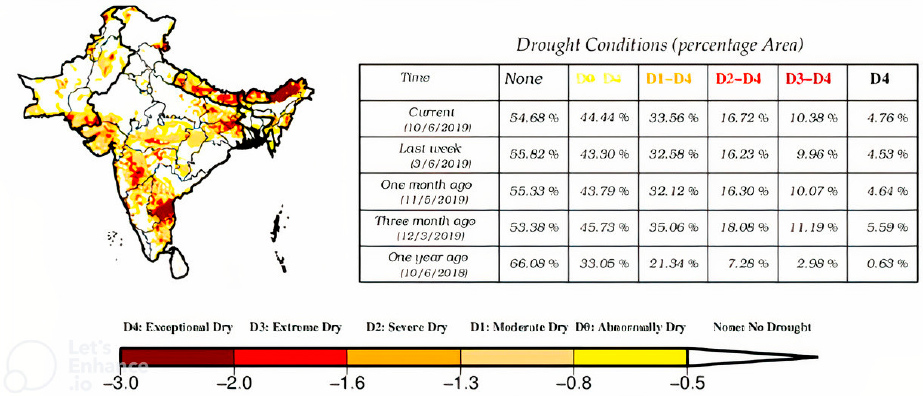
Figure 1. Drought affected areas of India in June 2019 (Source: DEWS https://sites.google.com/a/iitgn.ac.in/high_resolution_south_asia_drought_monitor/drought-early-warning-system (accessed on 4 December 2022)).